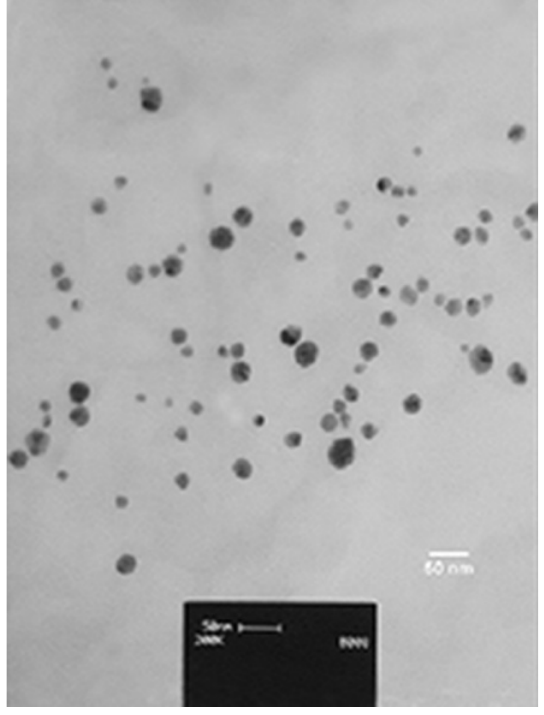
Figure 8: TEM image of the synthesized AuNPs using mushroom extract at obtained optimum conditions.